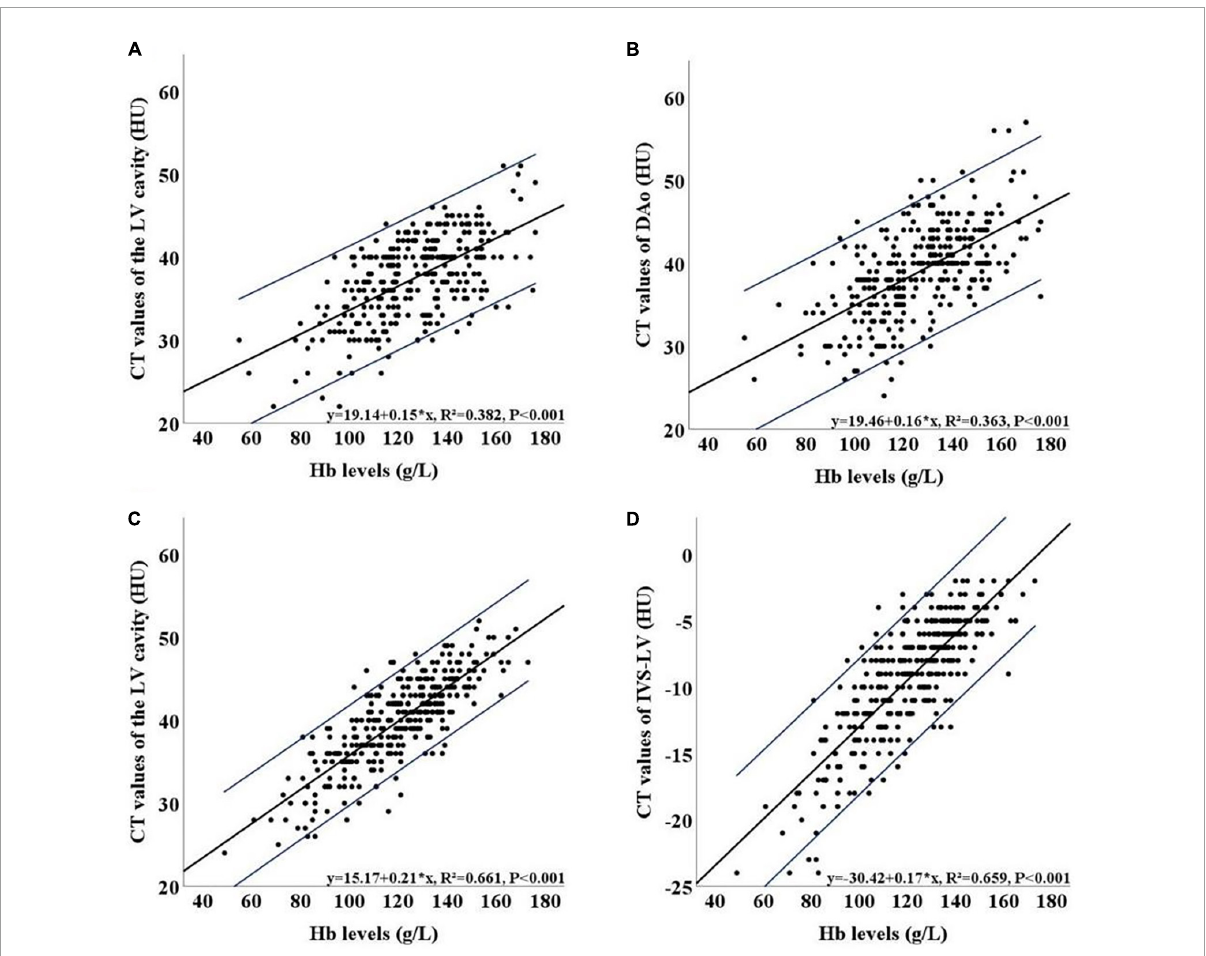
FIGURE3 Scatter plots of the relationship between Hb level and the LV (A) and between Hb level and DAo (B) in the LDCT group. Scatter plots of the relationship between Hb level and the LV (C) and between Hb level and IVS-LV (D) in the CDCT group. 95% CI of the estimation equation is shown indicated in blue lines. LDCT, low dose computed tomography; CDCT, conventional dose computed tomography; LV, left ventricular cavity; IVS-LV, CT attenuation difference between LV and IVS; DAo, descending aorta; HU, Hounsfield Unit; Hb, hemoglobin; 95% CI, 95% confidence